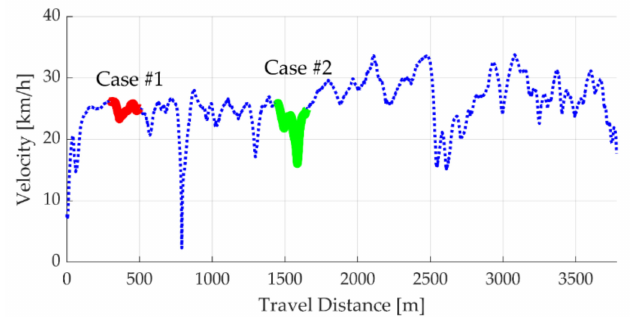
Figure 6. Reference velocity with Case #1 and Case